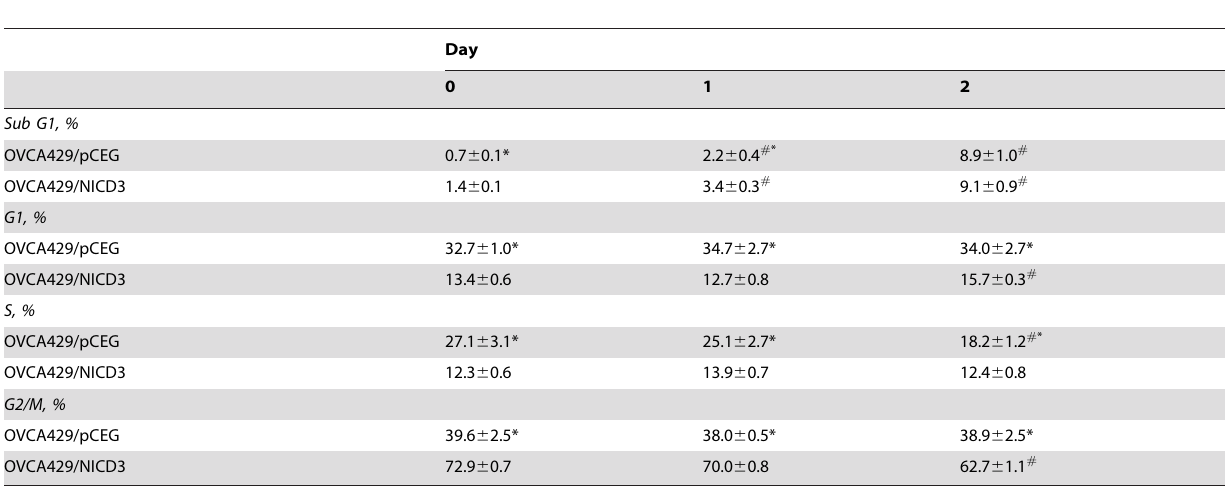
Table 3. Flow cytometric analyses of the percent G1, S, and G2/M OVCA429/pCEG and OVCA429/NICD3 cells co-treated with